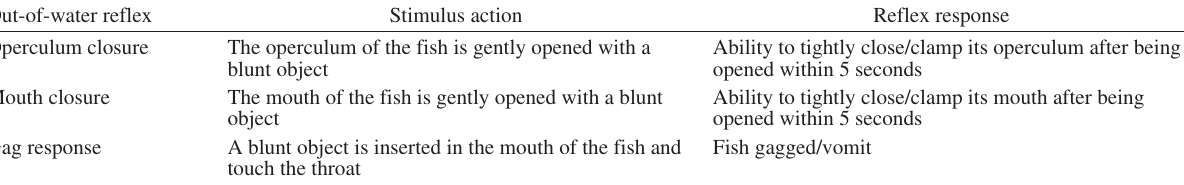
Table 2. – Reflex responses tested out of water, with a description of the implemented stimuli and expected responses if the reflex was present (adapted from Catchpole et al. 2015 and Davis 2010). Out-of-water